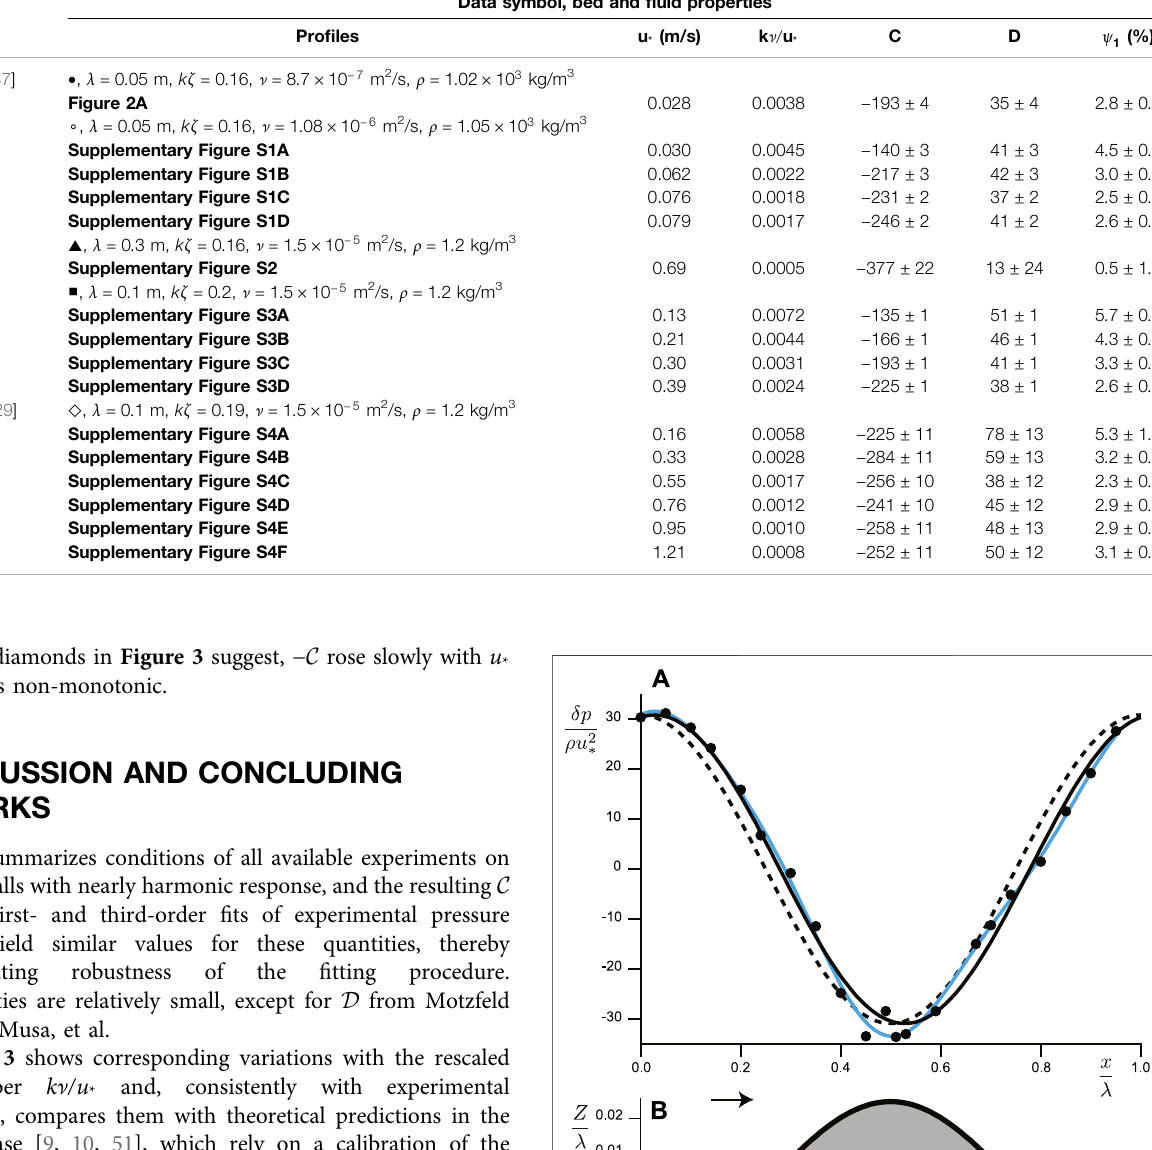
TABLE 1 | Experimental conditions and values of C and D inferred from harmonic fi ts of pressure pro fi les using Eqs 7 , 8 . Last column: downwind shift relative to bed wavelength ψ 1 (cid:2) ϕ 1 / ( 2 π ) , calculated from tan ( 2 πψ 1 ) (cid:2) − D / C .